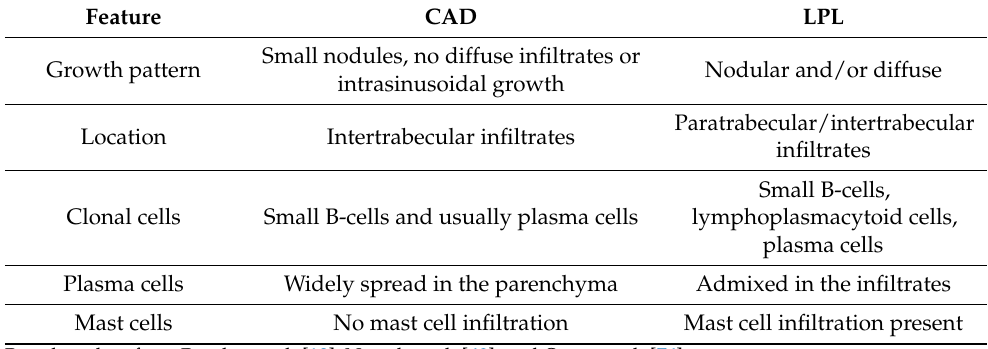
Table 1. Bone marrow histopathologic features in CAD and